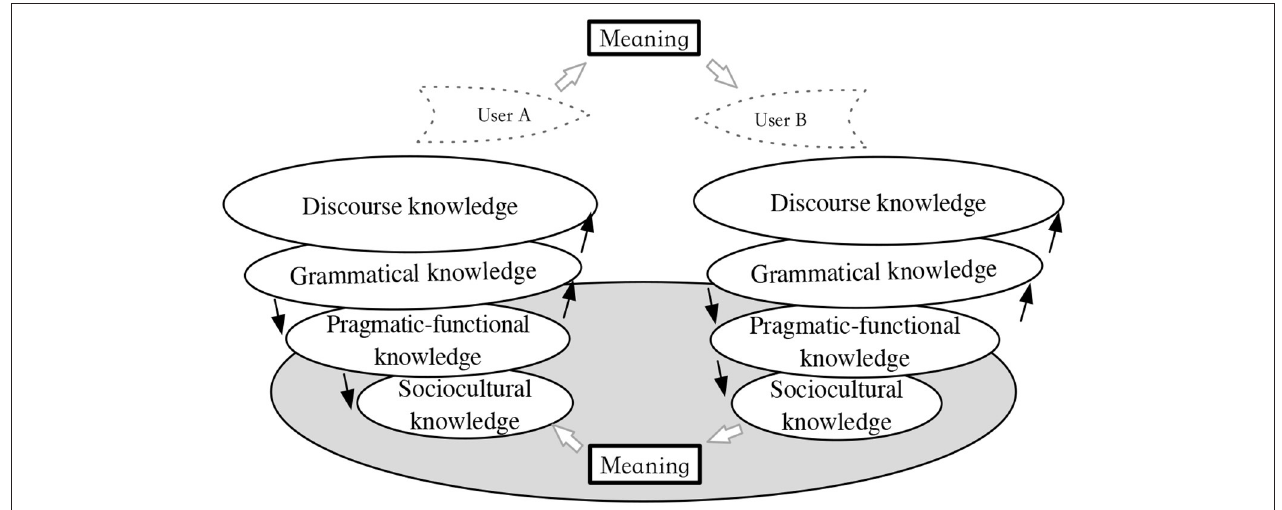
FIGURE 1 | Componential and meaning-driven model (Timpe et al.,